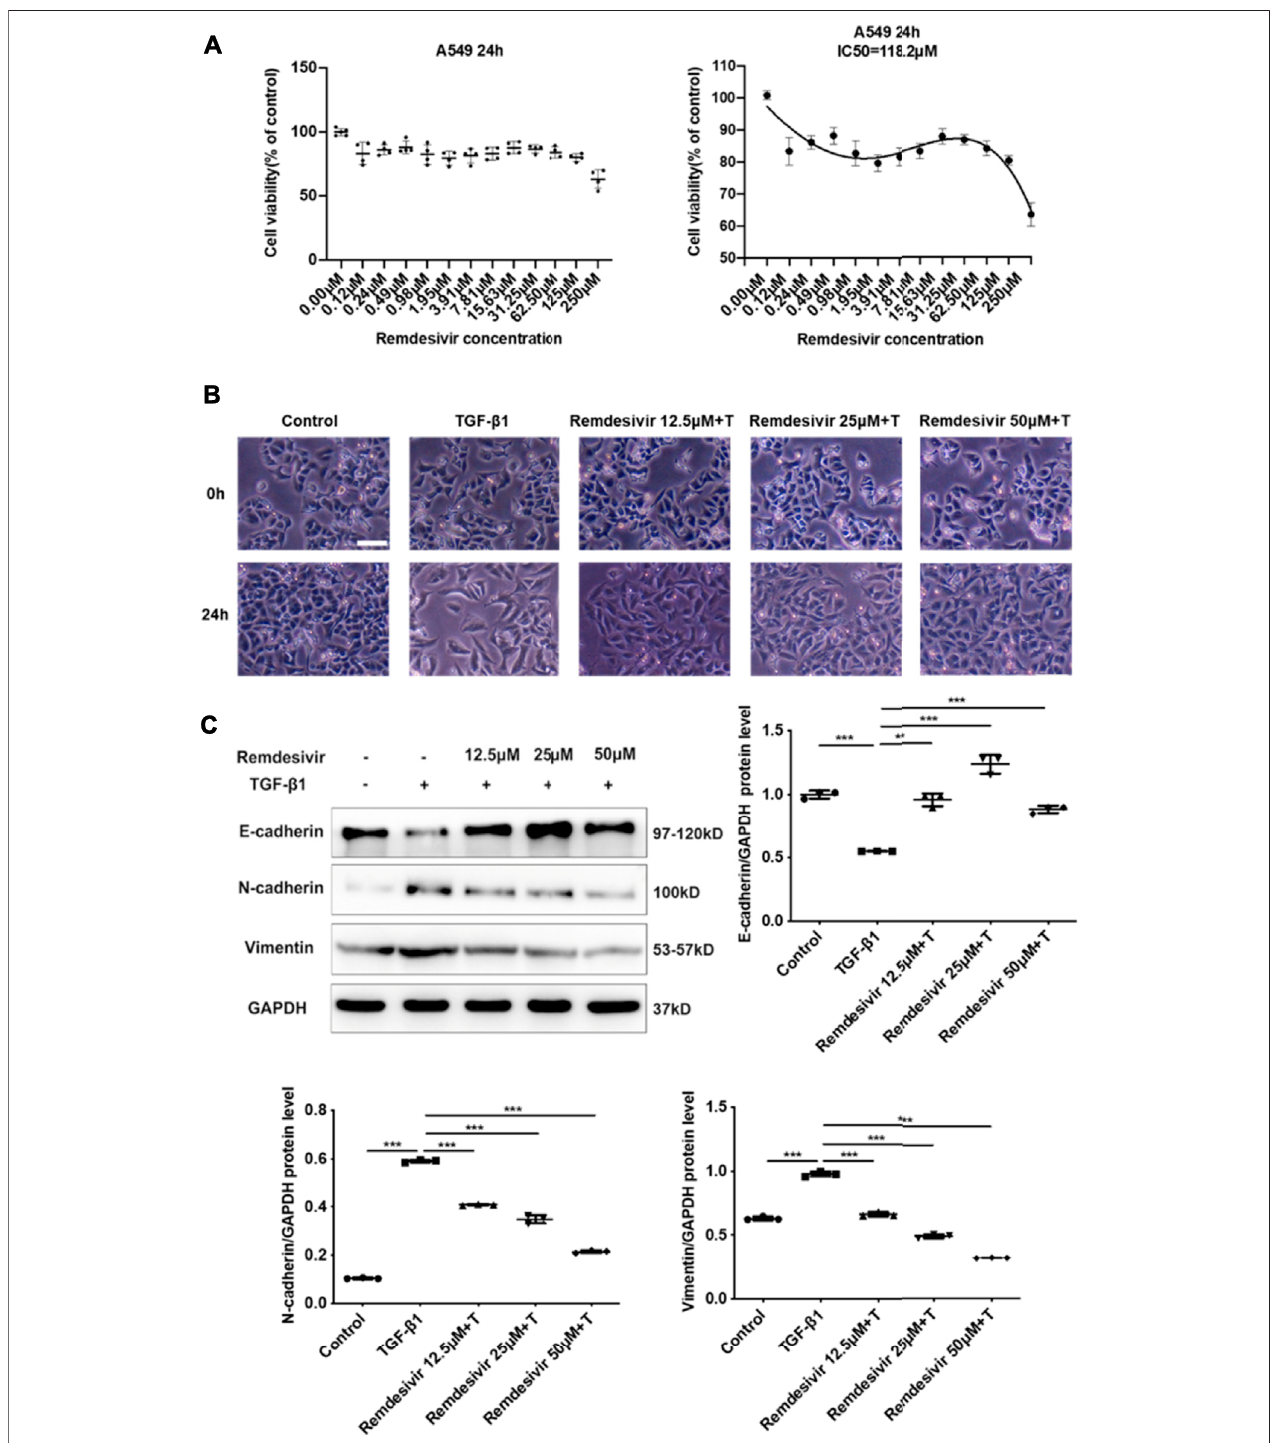
FIGURE7| RemdesivirinhibitsTGF- β 1-inducedepithelialtomesenchymaltransitioninalveolarepithelialcells (A) MTTassaysofA549cells.Cellswereexposedto the indicateddoses ofRemdesivir (0 – 250 μ M) for24h, IC 50 (cid:1) 118.2 μ M( n (cid:1) 4per group) (B – C) A549cellswereco-treated withRemdesivir (12.5,25, 50 μ M) and TGF- β 1(5 ng ml − 1 ) for24 h (B) MorphologicalchangesofA549cells. (C) Protein expression levels ofE-cadherin, Vimentinand N-cadherin wereassessed byWestern blot in A549 cells. GAPDH was used as a loading control. Data was presented as the means ± SD, n (cid:1) 3. * p < 0.05, ** p < 0.01, *** p < 0.001, **** p < 0.0001.